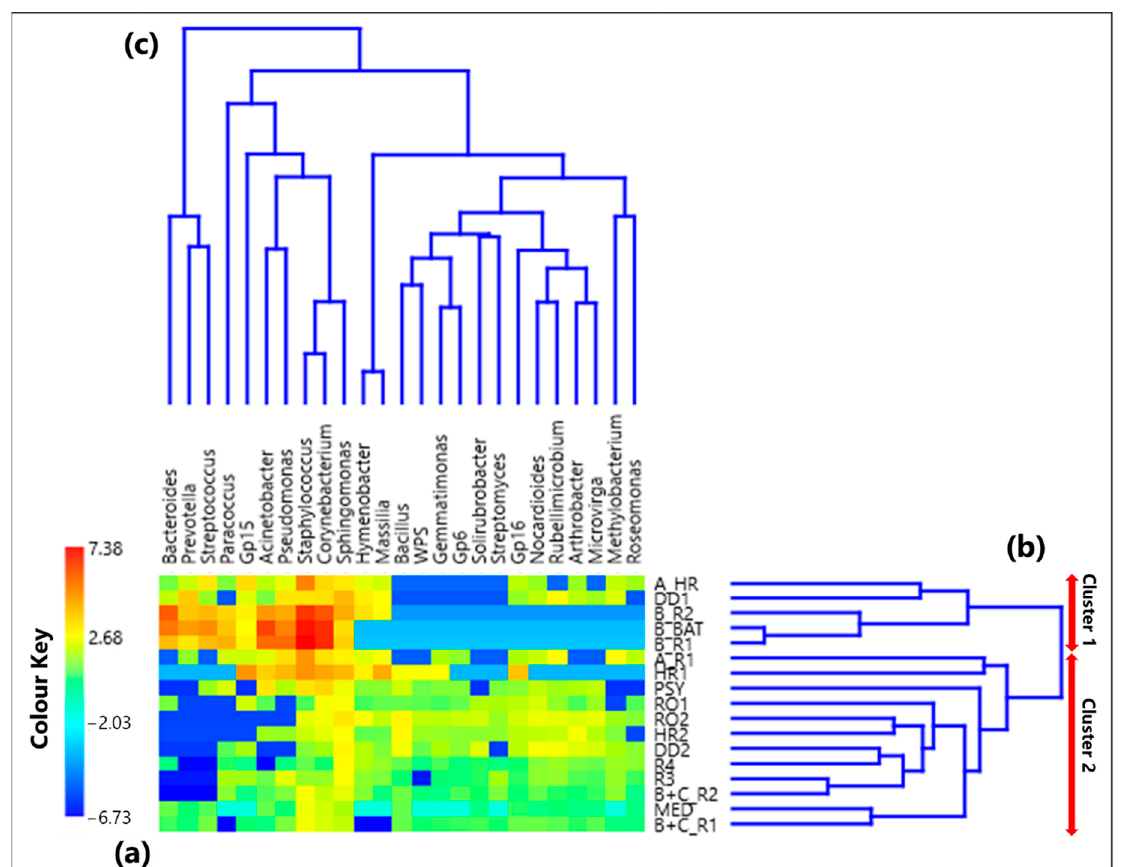
Figure 1. ( a ) Heatmap based on the centered log-ratio (CLR) transformed values of the 25 selected bacterial genera; ( b , c ) show the Aitchison distance-based dendrograms highlighting the relatedness between different samples and genera, respectively. The red arrows in ( b ) allow identifying the two main sample clusters identified by the dendrogram, where Cluster 1 includes the samples A_HR, DD1, B_R2, B_BAT, and B_R1, and Cluster 2 consists of all the other samples. WPS in the genus legend stands for